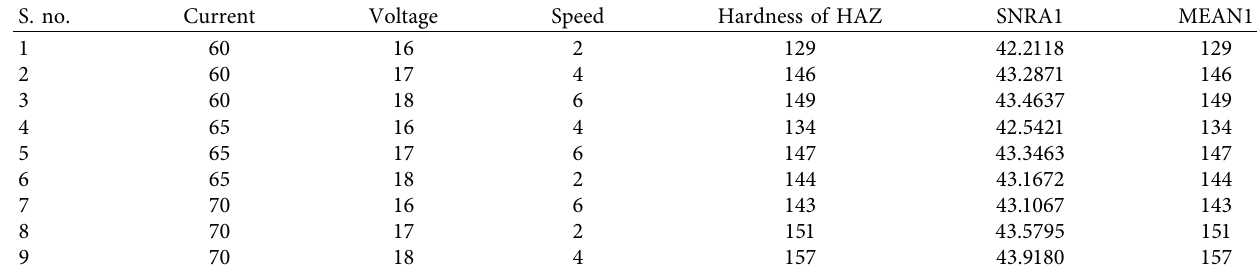
Table 9: Hardness of HAZ reading and S/N ratio.